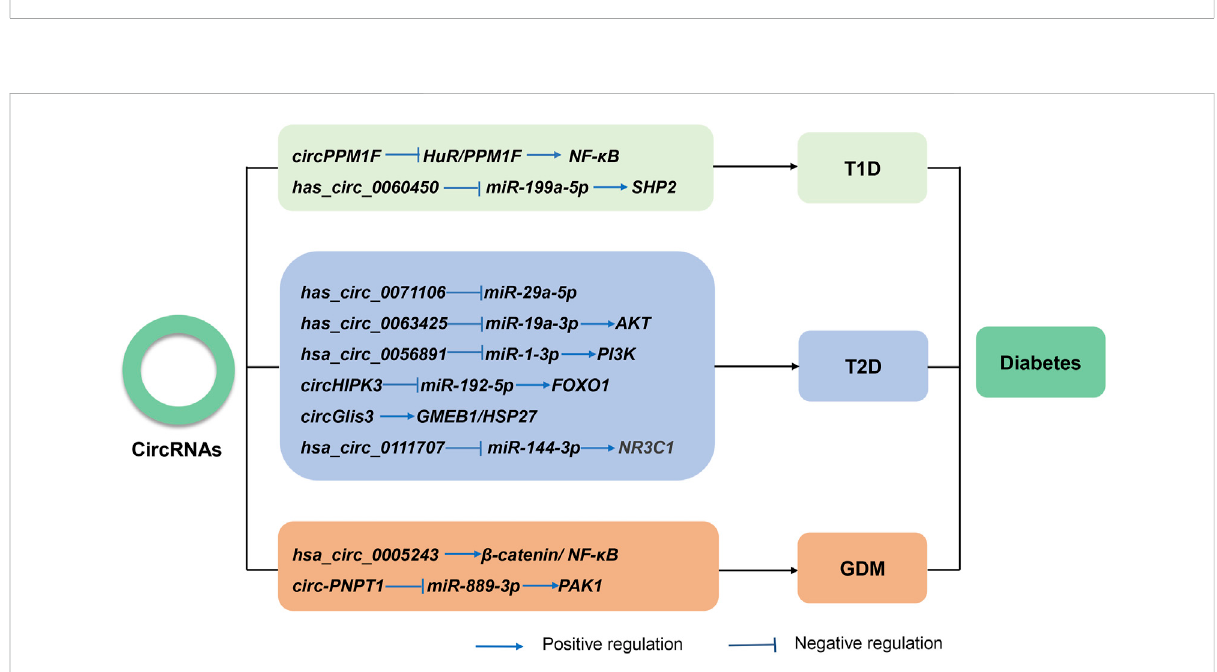
The known roles and regulatory pathways of circRNAs involved in type 1 diabetes (T1D), type 2 diabetes (T2D), and gestational diabetes mellitus